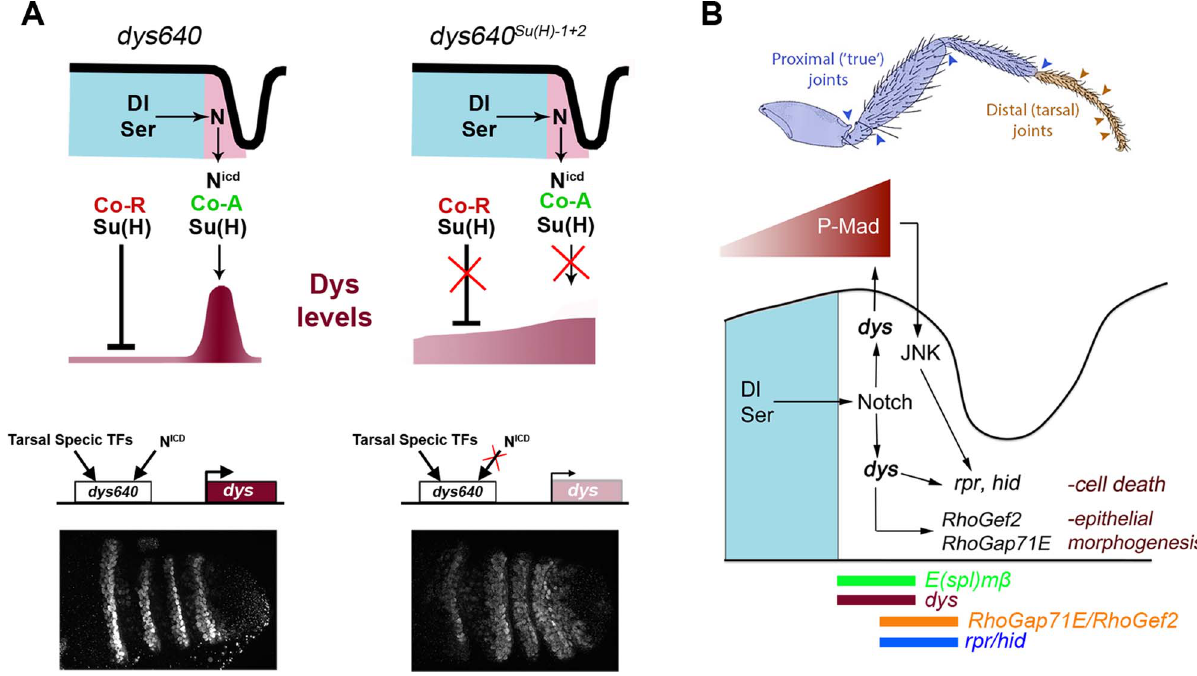
Figure 8. dys molecular regulation and model for tarsal joint development. (A) Schematic representation of a tarsal joint of a dys640 wild type (left) and dys640 Su(H)-1 + 2 where the two Su(H) binding sites are mutated (right). See text for description. (B) Model for tarsal joint formation. Blue and brown arrowheads mark proximal and distal joints, respectively. In a tarsal joint, Notch ligands Dl and Ser (blue) activate the Notch pathway in the distal adjacent cells. Notch, in turn, activates dys expression, which regulates the high levels of P-Mad observed in the joint. Dys also controls the expression of the pro-apoptotic genes rpr and hid and the RhoGTPases modulators RhoGef2 and RhoGap71E . The sharp boundary of Dpp signaling also regulates rpr expression via JNK pathway activation. The expression domains of E(spl)m b , dys , rpr , hid , RhoGef2 and RhoGap71E are indicated.